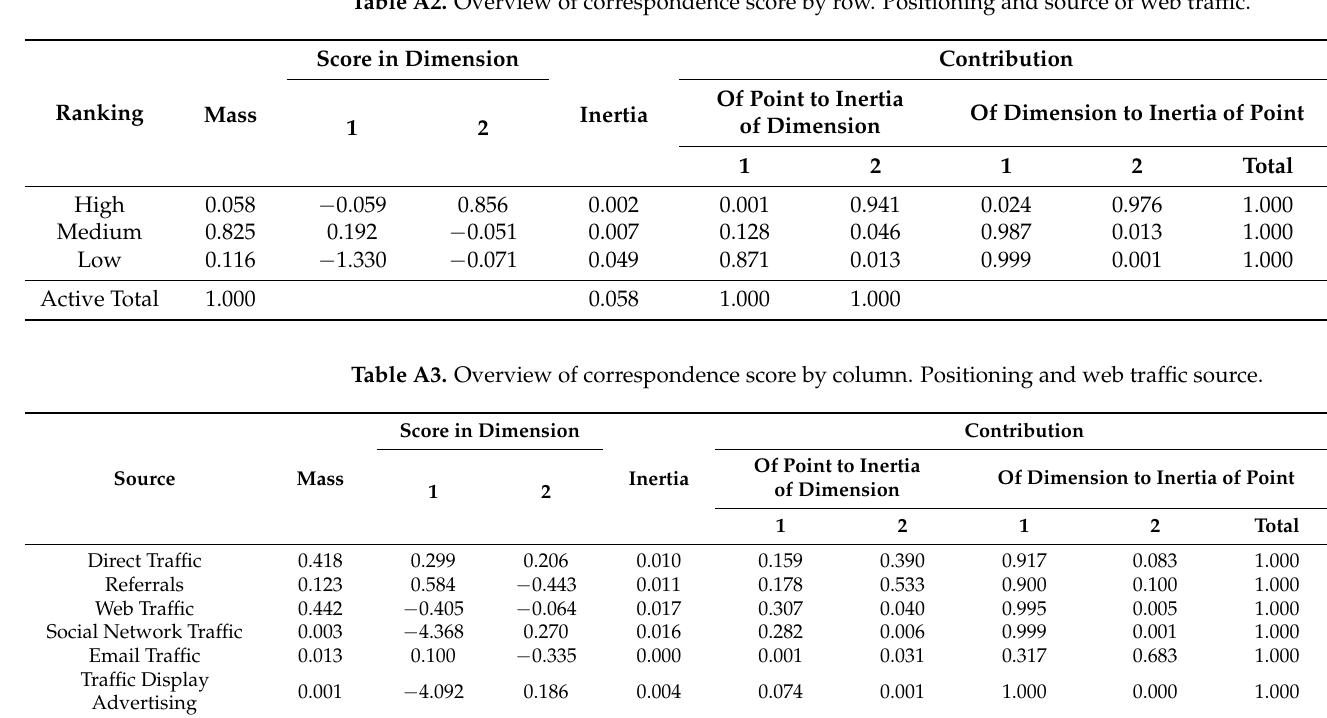
Table A2. Overview of correspondence score by row. Positioning and source of web traffic.